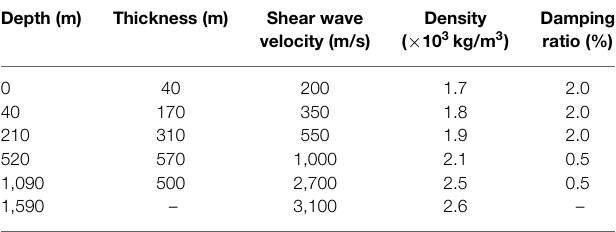
TABLE 5 | Soil conditions at Kita-ku, Osaka.